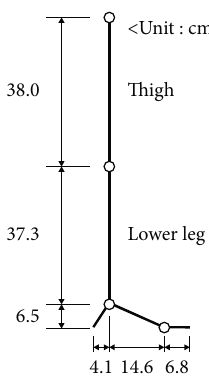
Figure 1: Dimensions of the lower knee